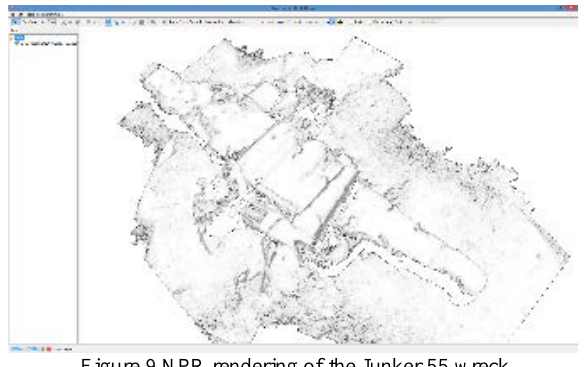
Figure 9 NPR rendering of the Junker 55